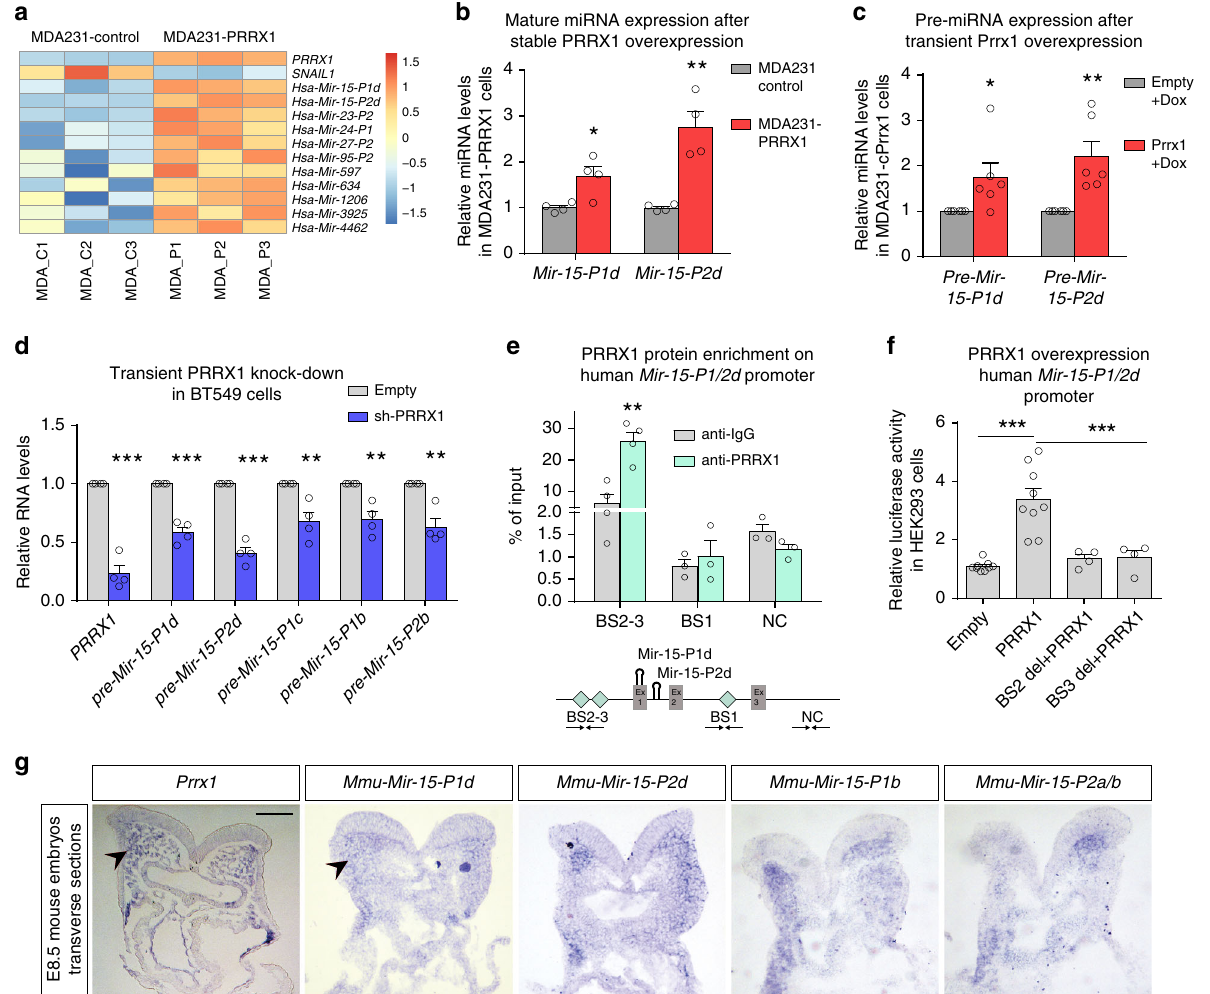
Fig. 3 Prrx1 directly induces the expression of miR-15 family. a Heatmap showing Robust Multi-array Average (RMA) normalized probe intensity values of PRRX1 , SNAIL1 , and selected miRNAs in MDA231 cells, with three control samples (MDA_C1 to C3) and three samples in which PRRX1 was overexpressed (MDA_P1 to P3). The intensities mapped as color scale show normalized fold change with respect to the average ( n = 3). b Validation by Taq-Man qPCR of Mir-15-P1d and Mir-15-P2d upregulation after PRRX1 stable overexpression in MDA231 cells lines, using speci fi c probes to detect the mature miRNAs ( n = 4). c Mir-15-P1d_pre and Mir-15-P2d_pre upregulation upon conditional (Dox-mediated) Prrx1 overexpression in MDA231 cells ( n = 6). d qPCR assay showing downregulation of PRRX1 and premiRNAs transcription upon transient knockdown (KD) of PRRX1 in BT549 cells. PRRX1 shRNA plus YFP transfected cells were sorted after 4 days ( n = 4). e PRRX1 directly binds to the human Mir-15-P1/2d promoter as shown by ChIP assay in BT549 cells using a PRRX1 speci fi c antibody. Cyan diamonds in the schematic map represent distances between PRRX1 potential BSs and the promoter potential motifs, TAATKDS, on Mir-15-P1/2d promoter. (BS1: − 293, BS2: − 949, BS3: − 1451 and NC: + 1893). Ex1 – 3 represent exons of the host long noncoding RNA MIR503HG . Arrows represent primer sets used for ChIP detection. ( n = 3 except for BS2 – 3 for which n = 4). f Activation of human Mir-15-P1/2d promoter by PRRX1 overexpression shown by dual luciferase assay in HEK293 cells. This activation is abolished upon deletion of the PRRX1 binding sites in Mir-15-P1/ 2d promoter (del1/2 + PRRX1) ( n = 4 except for deletions for which n = 4). g Transverse sections of the cranial region of E8.5 embryos showing the expression of Prrx1 , Mir-15-P1d , Mir-15-P2d , Mir-15-P1b , and Mir-15-P2a/b in similar regions (arrowheads). Scale bar: 100 μ m. Dox doxycycline, sh short hairpin RNA (shRNA), BS binding site, del deletion. Bars represent mean plus SEM, indicated ( n ) represent number of independent experiments as biological replicates and asterisks indicate signi fi cant p value in t test for ( b – e ) and one-way ANOVA with Bonferroni ’ s multiple comparison test for ( f ). (* p < 0.05, ** p < 0.01 and *** p < 0.001). Source data are provided as a Source Data fi